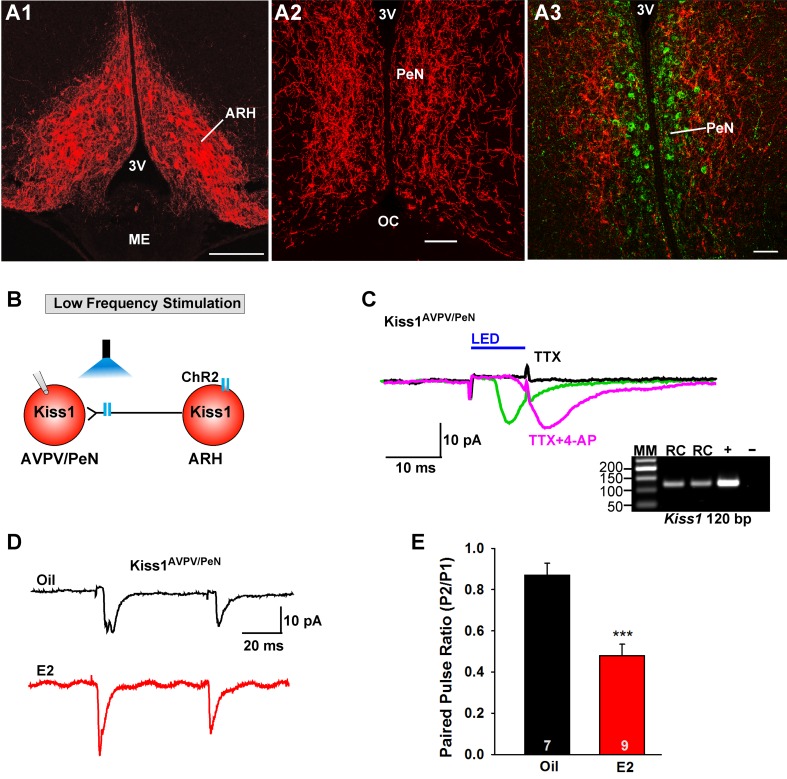
E2 treatment increases the probability of glutamate release from Kiss1ARH neurons onto Kiss1AVPV/PeN neurons.(A1-A2) Photomicrographs showing the pronounced projections of ChR2:mCherry fibers to the preoptic area including the PeN following bilateral injections of AAV1-DIO-ChR2:mCherry in the ARH of Kiss1CreGFP V2 mice (note that the GFP was not visible in the V2 animals). Therefore, some POA sections from the same animals were stained for kisspeptin using the Caraty 564 antibody and revealed immunoreactive Kiss1 neurons in the PeN (green cells) (A3). Essentially none of the POA somas including the Kiss1 cells expressed ChR2-mCherry. Scale bars = 100 µM (A1,A2); 50 μm (A3). (B) schematic of photostimulation of the terminals of Kiss1ARH neurons and recording of Kiss1AVPV/PeN neurons. (C) following AAV1-DIO-ChR2:YFP (or mCherry) injection into the ARH, a fast inward current was recorded in Kiss1AVPV/PeN neurons following blue light stimulation (green trace). The response was antagonized by CNQX (10 µM) and AP5 (50 µM) (not shown) and was abrogated in the presence of TTX (1 µM, black trace) but rescued with the addition of the K+ channel blocker 4-AP (100 µM, magenta trace; n = 4 neurons). (D) using a paired-pulse regime (two blue light pulses of 5 ms duration separated by 50 ms), fast glutamatergic inward currents were recorded in Kiss1AVPV/PeN neurons (Vhold = −60 mV) from both oil-treated, OVX (upper trace, black) and E2-treated, OVX (lower trace, red) females. The averaged responses (50 sweeps) are shown. (E) E2-treatment significantly decreased the paired-pulse ratio (P2/P1) indicating that there was a higher probability of glutamate release from arcuate Kiss1Cre:ChR2 neurons (Unpaired t-test, t(14) = 4.748, p<0.001). ***p<0.001. Inset shows scRT-PCR post hoc identification of representative recorded Kiss1AVPV/PeN neurons. RC, recorded cell; +, positive control (with reverse transcriptase); -, negative control (without reverse transcriptase); MM, molecular marker.10.7554/eLife.35656.012Figure 6—source data 1.The paired-pulse ratio (P2/P1) for Figure 6E.